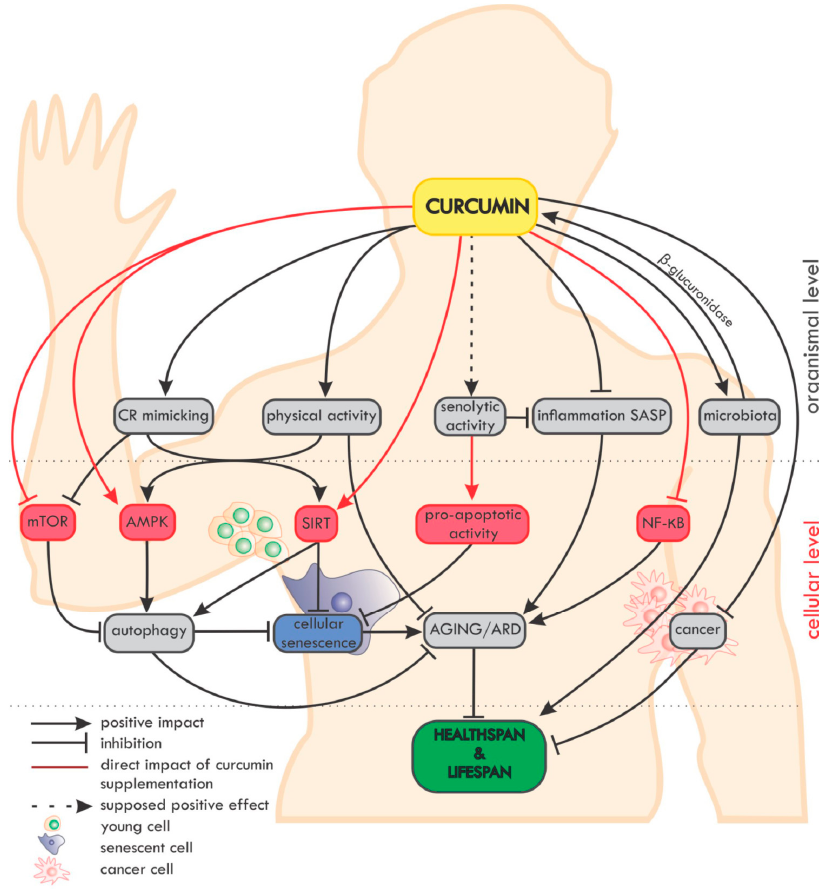
Figure 2. Overview of the impact of curcumin on ageing and age-related diseases (ARD) at the organismal and cellular level. On the organismal level, curcumin mimics caloric restriction (CR) and improves the effectiveness of physical activity (which in fact mimics CR). The potential senolytic activity of curcumin is still unclear, but curcumin can reduce inflammation and SASP, which are also